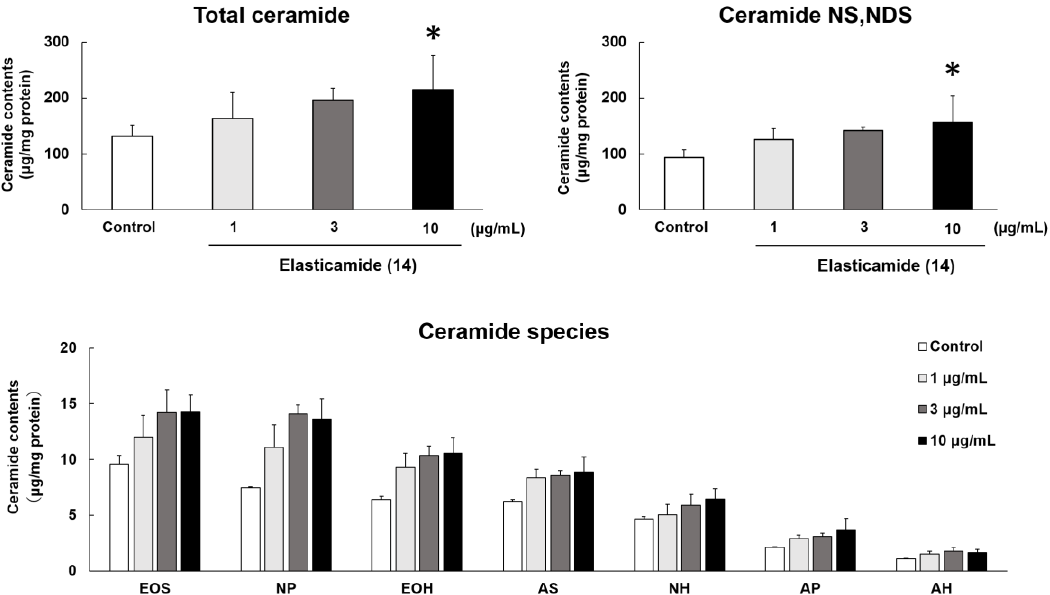
Figure 5. Effects of elasticamide ( 14 ) on SC ceramide contents in the RHEK model. The RHEK model was treated for 7 days with 14 (1, 3, and 10 µg/mL). The extraction of lipids from the SC of the RHEK model and a HPTLC analysis were performed as described in the Materials and Methods section. Data are expressed as means ± S.E. (n = 3–4). Asterisks denote a significant difference from the control group, * p < 0.05.